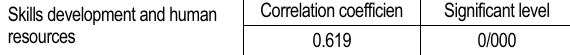
Table 7. Spearman correlation coefficient test Correlation coefficien Significant level Skills development and human resources 0.619 0/000